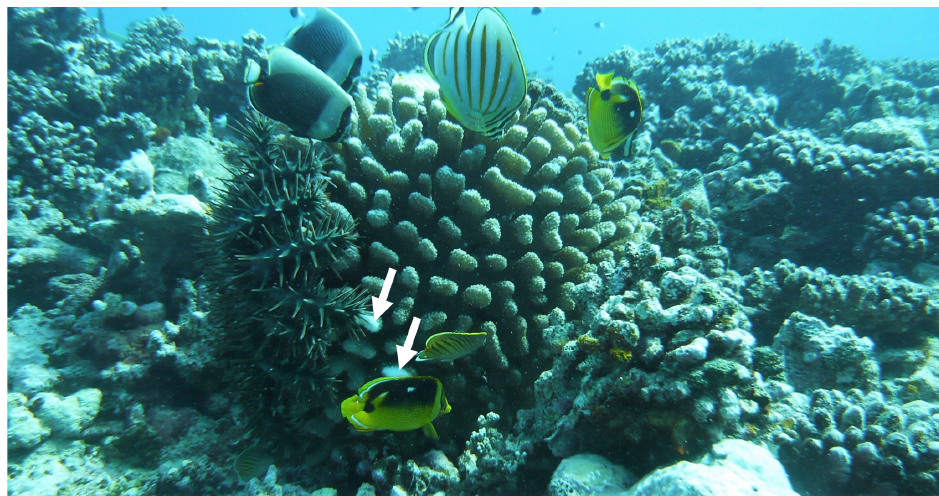
Figure 2. Aggregation of a diversified guild of 10 macro-predators simultaneously feeding upon a guarded coral. This aggregation was observed following widespread coral decline (note the absence of live coral in the background) in August 2008 at 12 m depth on Tiahura reef in Moorea, French Polynesia. The guarded coral measured approximately 70 cm in diameter. The predator guild was composed of a crown-of-thorns seastar (COTS) and nine butterflyfishes from species Chaetodon ornatissimus, C. pelewensis, C. quadrimaculatus, C. reticulatus. Arrows indicate white feeding scars characteristic of recent COTS predation on the guarded coral ( Pocillopora eydouxi